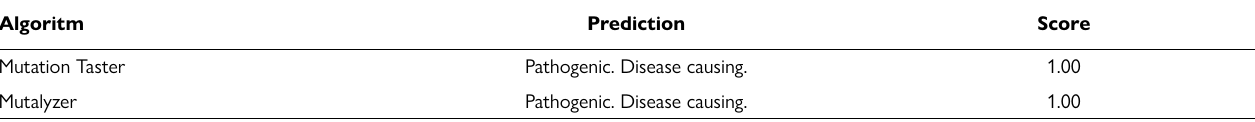
Table 2. Results of in silico mutation prediction analysis (c.3G>A, p.Met1?). Algoritm Prediction Score Mutation Taster Pathogenic. Disease causing.